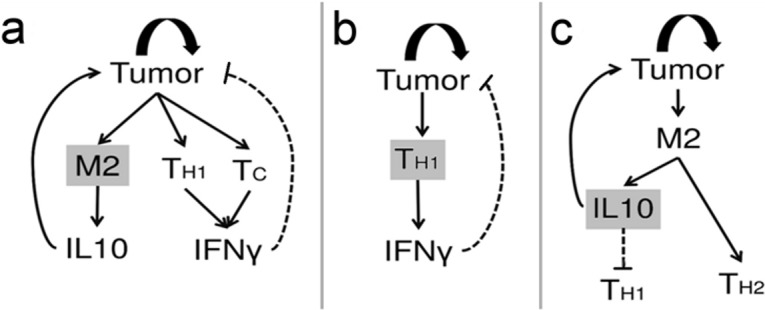
Regulatory feedback loops.(a) The M2 macrophage triggers two feedback loops. The first loop through IL10 is a positive feedback that triggers tumor proliferation. This, in turn, activates the second loop through IFN- γ that inhibits the tumor; (b) The TH1 derived IFN- γ inhibits the tumor via a negative feedback that leads to an oscillation in the population of tumor cells; (c) The positive feedback loop through IL10 is responsible for the maintenance of tumor and suppression of TH1/ TH2 ratio.